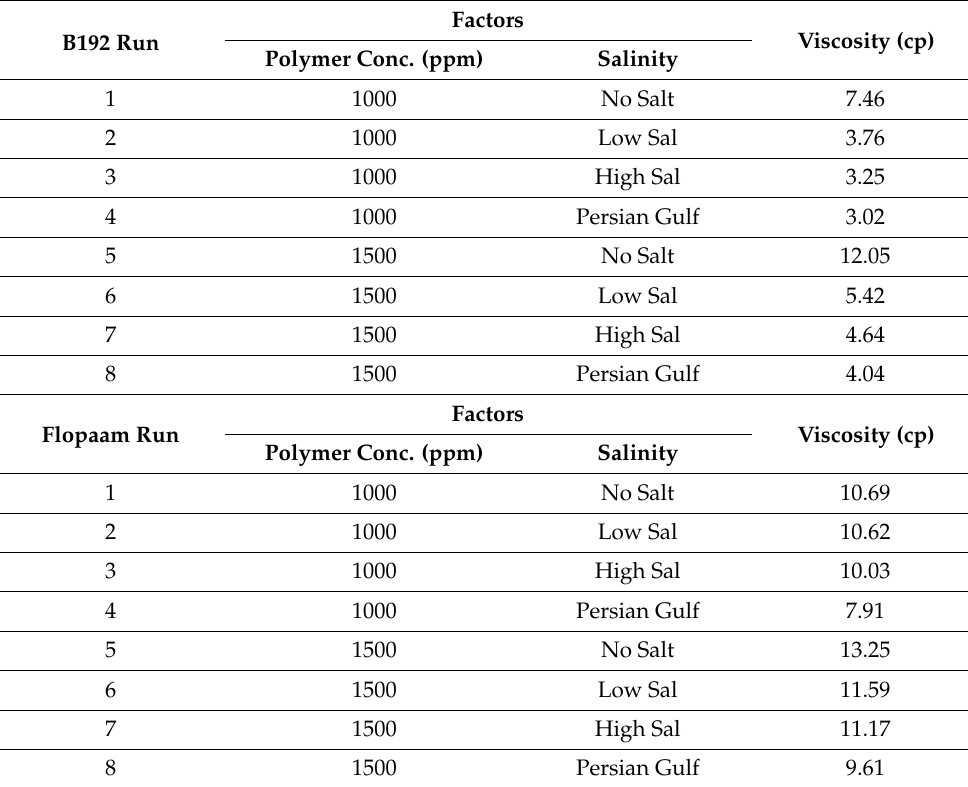
Table 4. Experimental design value with corresponding response (shear viscosity) for B192 and Flopaam 3630S.